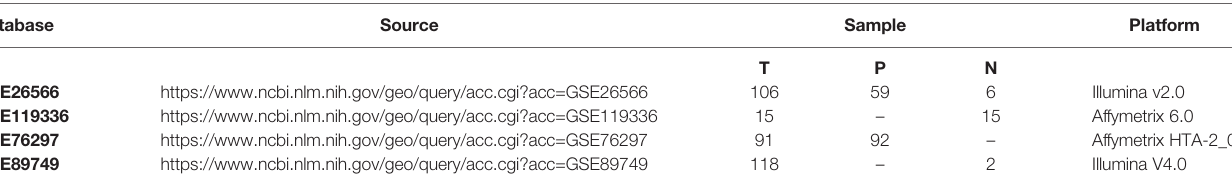
TABLE 1 | GEO datasets enrolled in the study.